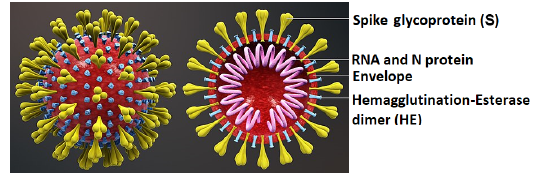
Fig. 1 Structure of